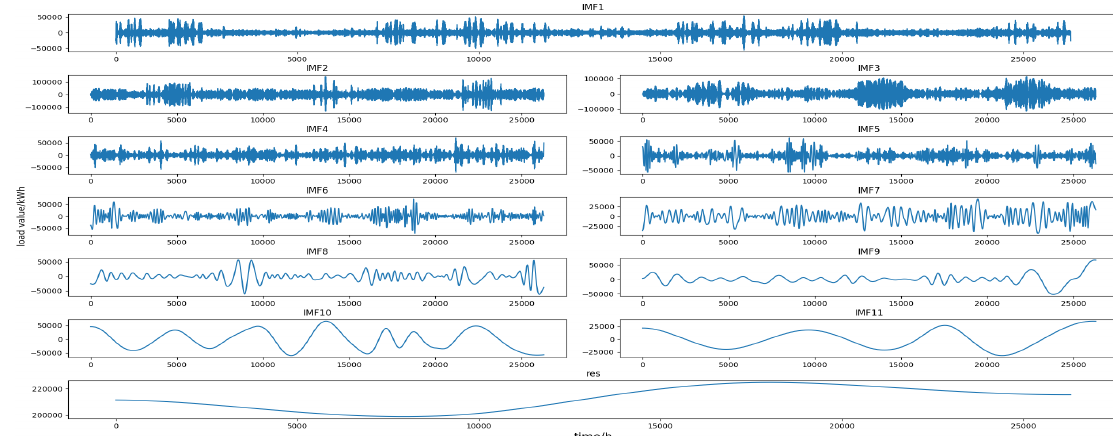
Figure 6. M_2 load series decomposition